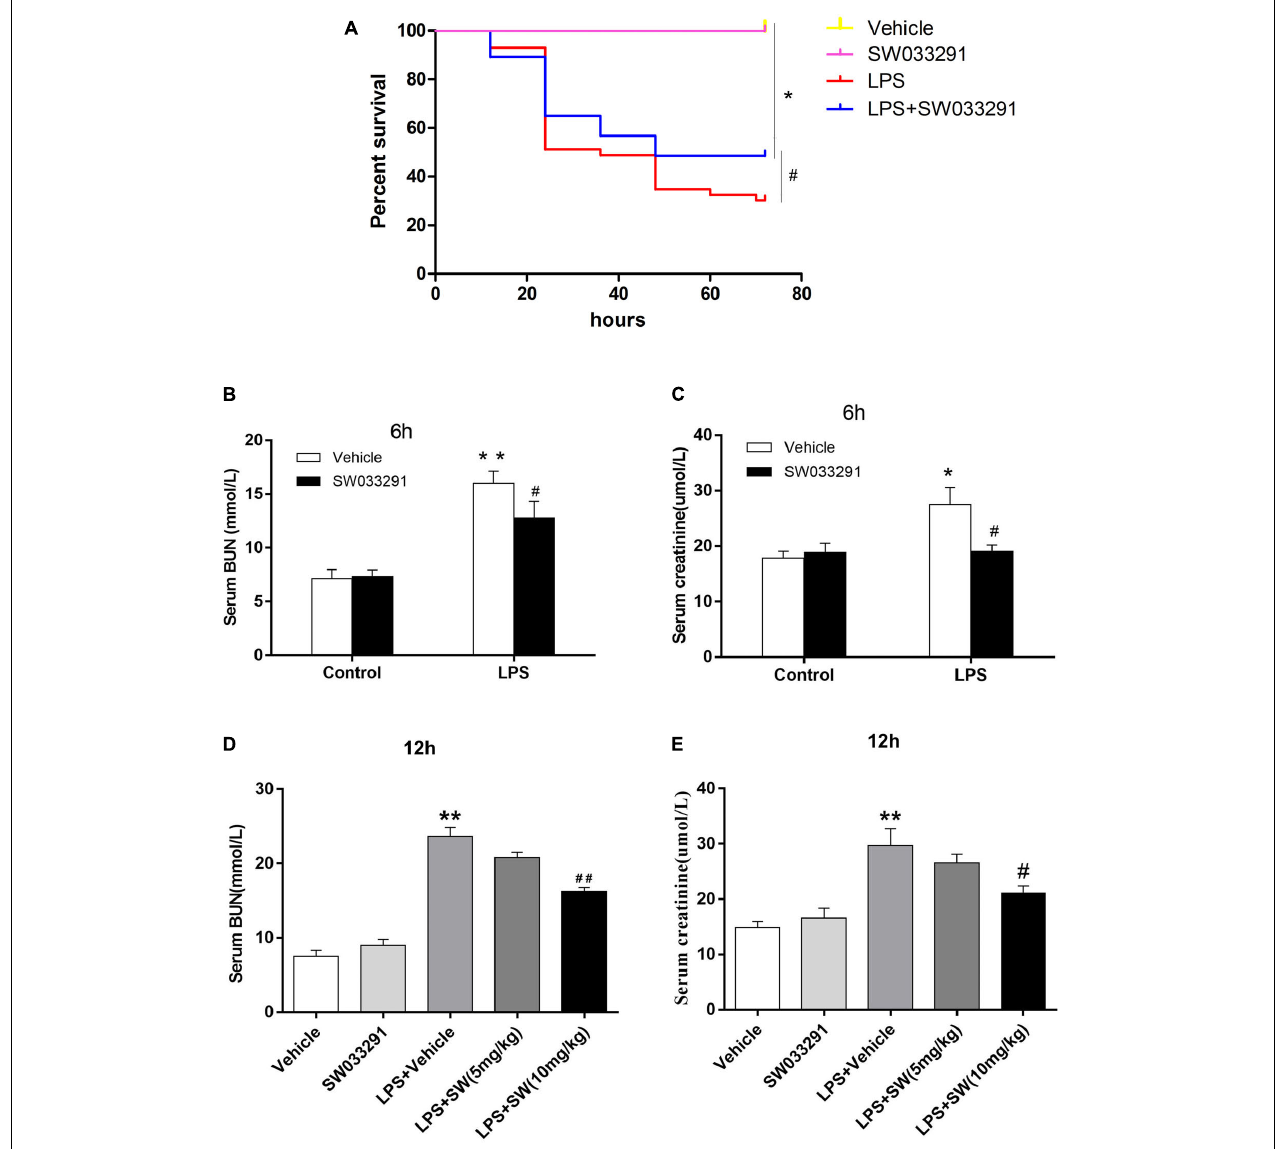
FIGURE 3 | Effect of SW033291 treatment on the survival rate and renal function in mouse sepsis model. (A) Effect of SW033291 (10 mg/kg injected twice daily IP for five doses) treatment on the survival of mice in sepsis model. * P < 0.01 (compared with control group); # P < 0.05 (compared with LPS group). n = 20 in control and SW033291 groups; n = 43 in LPS group; n = 37 in LPS + SW033291 group; (B,C) Serum levels of BUN and Cr in mice with LPS-induced AKI after 6 h of SW033291 (10 mg/kg) treatment ( n ≥ 6). (D,E) Serum levels of BUN and Cr in mice with LPS-induced AKI after 12 h of SW033291 (5 mg/kg or 10 mg/kg) treatment ( n ≥ 6). * P < 0.05, ** P < 0.01 (compared with control group); # P < 0.05, ## P < 0.01 (compared with LPS group). Groups were compared by Two-Way ANOVA. Data are mean ±